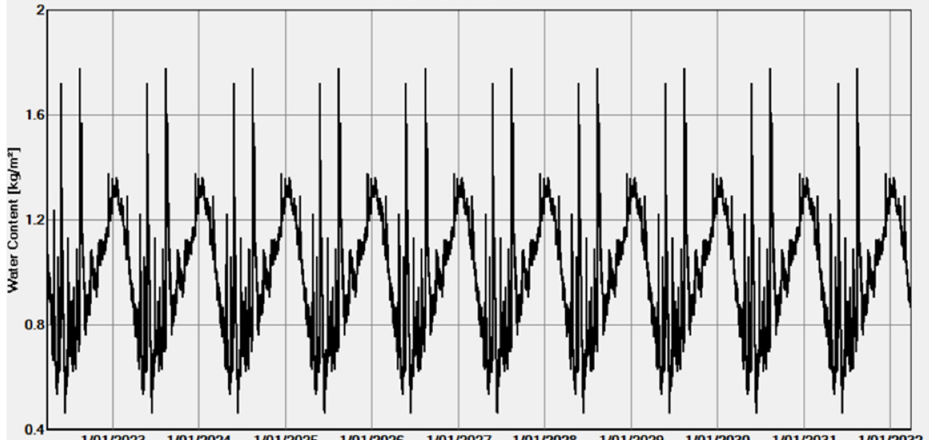
Figure 11. Graph of 10-year fluctuation of moisture content for the wall assembly in north orientation for pliable membrane A (single and multipoint).